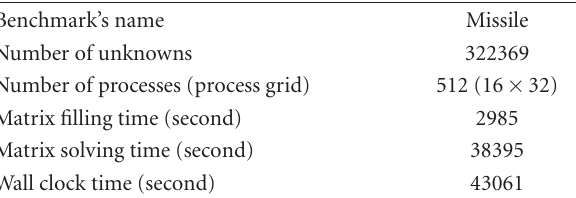
Table 7: Computation results of the simulated